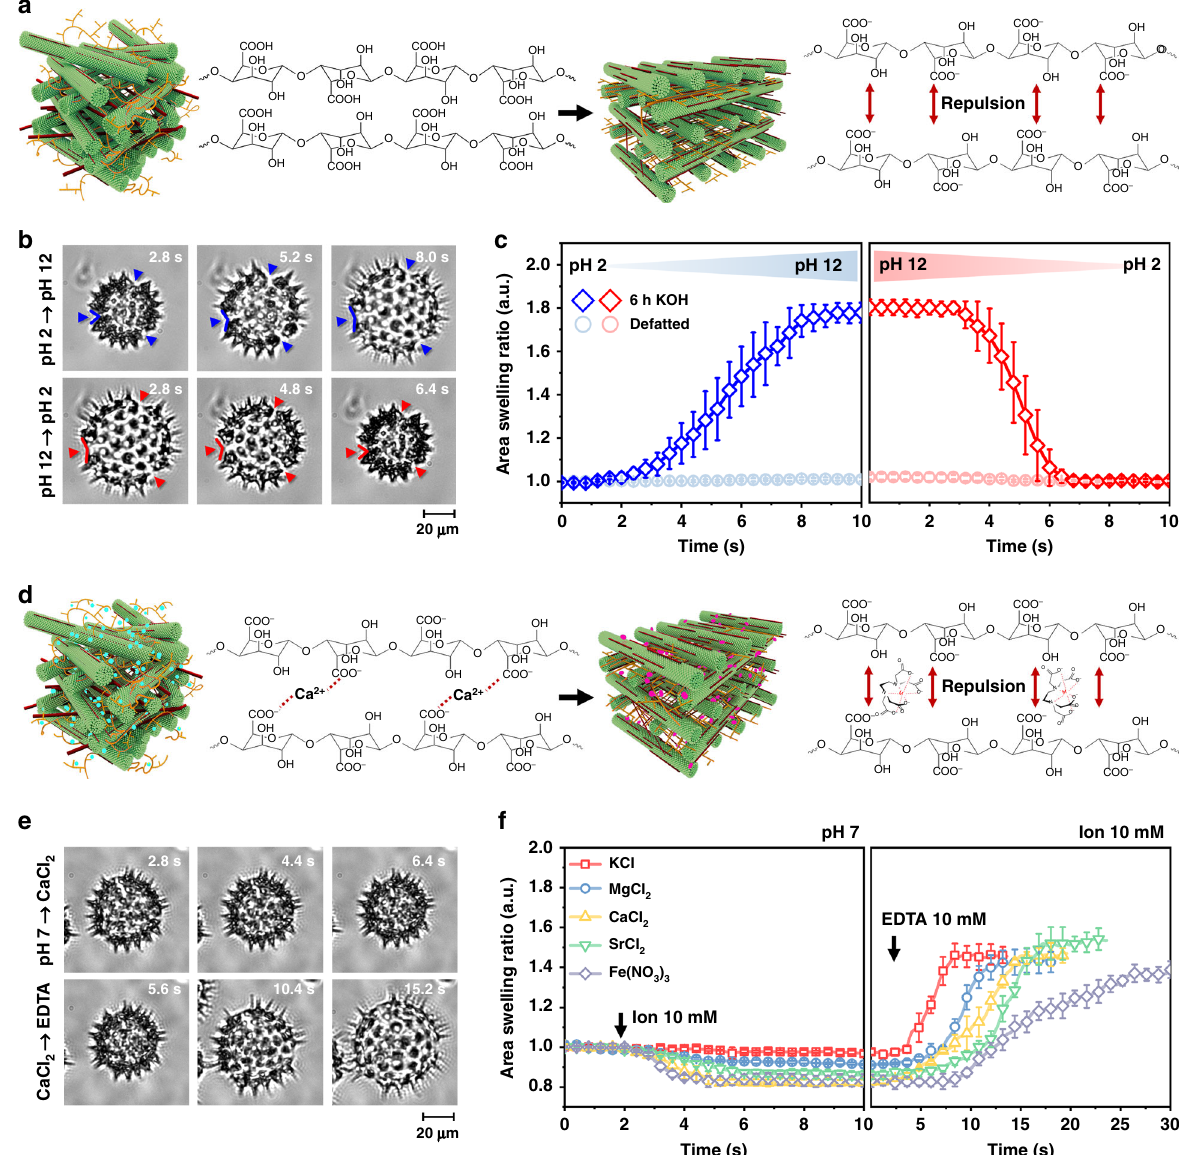
Fig. 2 Tunable pectate interactions enable rapid, stimuli-responsive material properties. a Schematic illustration of pH-dependent effects on pectin structure and corresponding intermolecular repulsion events. b Time-lapse optical micrographs of tethered pollen particles. The solution pH was changed from pH 2 to 12 (top series), and from pH 12 to 2 (bottom series). c Quantitative comparison of pH-induced pollen swelling and de-swelling behavior. d Schematic illustration of cation-induced attraction and EDTA chelating agent-induced repulsion between pectin molecules. e Time-lapse optical micrographs of tethered pollen particles. Calcium ions were added (top), followed by EDTA chelating agent (bottom). f Quantitative comparison of ion- induced pollen de-swelling and swelling behaviors. Mean ± s.d. are reported ( n = 5 particles) in c and f , and the area swelling ratio was normalized by the initial area at pH 2 and pH 7 in c and f , respectively. Source data are provided as a Source Data fi